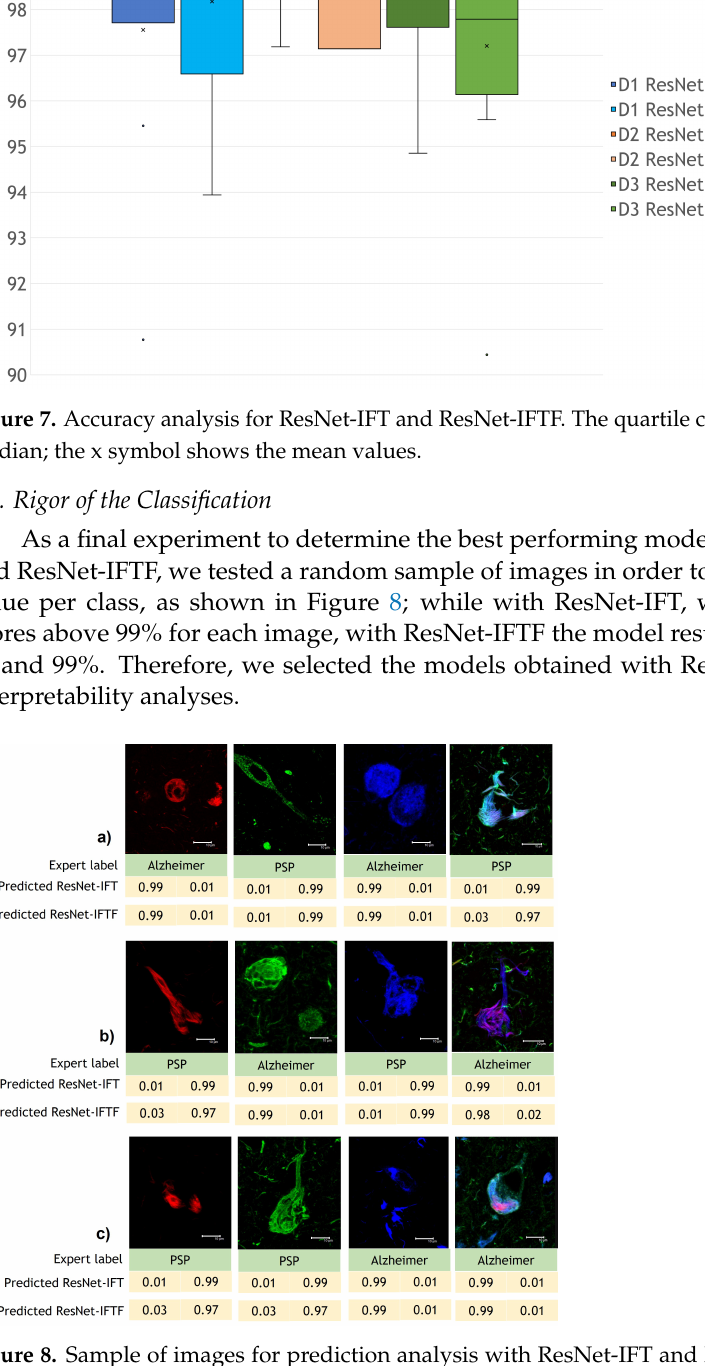
Figure 8. Sample of images for prediction analysis with ResNet-IFT and ResNet-IFTF. ( a ) Models developed using D1. ( b ) Models developed using D2. ( c ) Models developed using